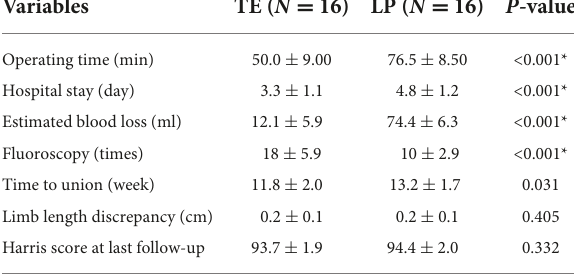
TABLE 2 Clinical parameters of the TE and the LP group.